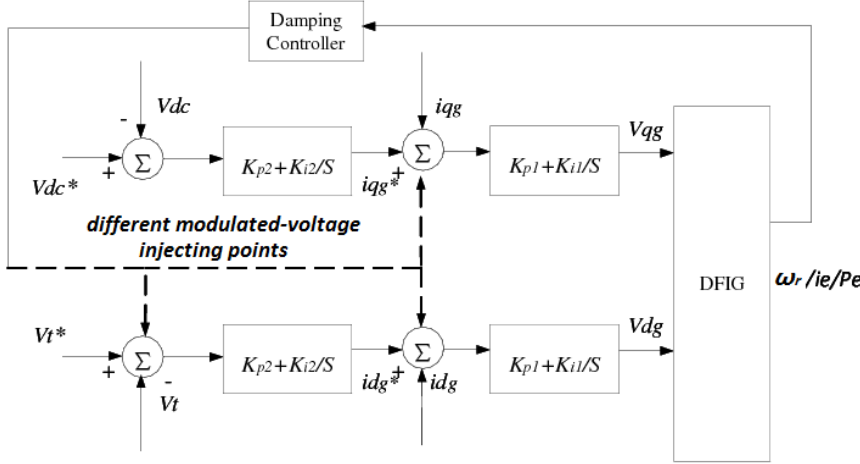
Figure 3. The supplementary control scheme in the GSC control loop for mitigating SSR with different feedback signals and the modulated-voltage injecting